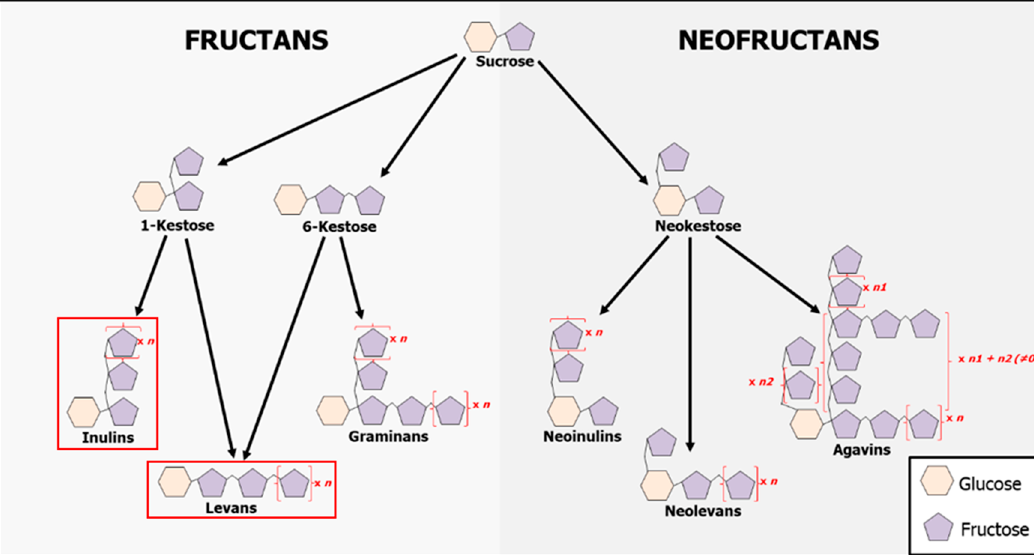
Figure 1. Schematic illustration of structural variants of fructans found in plants (adapted from [53]). Fructans are produced and stored in vacuoles. The fructan variants used in this work are highlighted by a red box. Their synthesis is carried out by enzymes named fructosyltransferases, whereas their degradation is done by fructan exohydrolases [46].